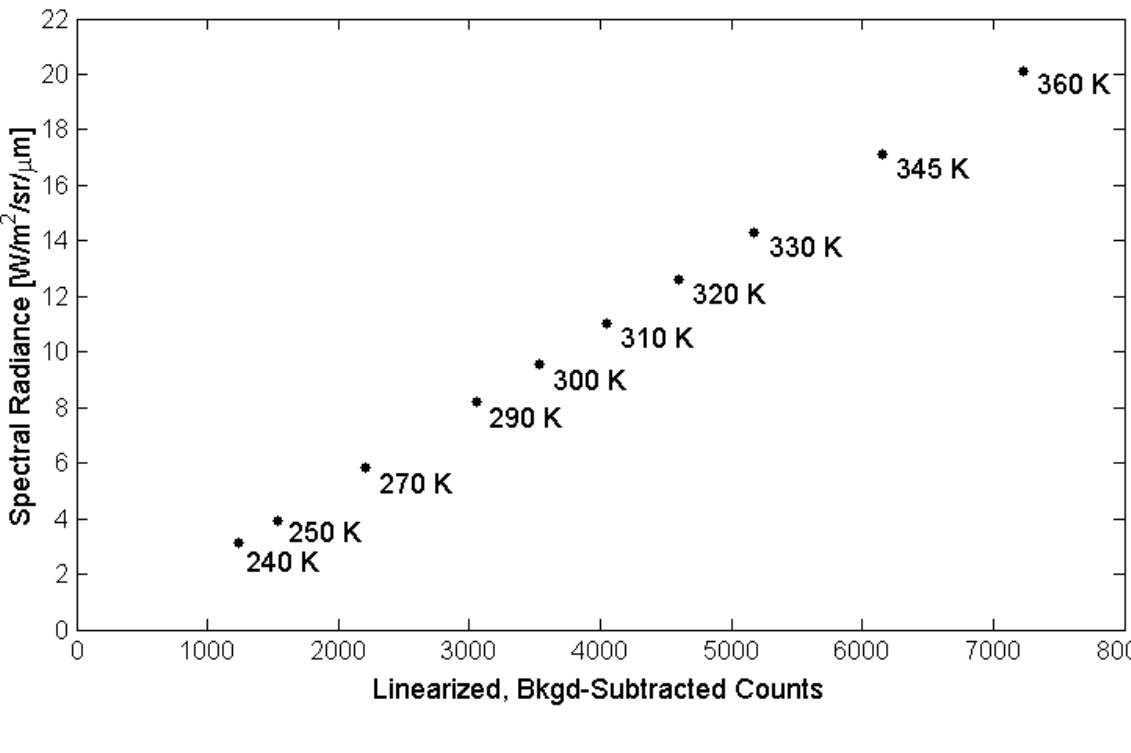
Figure 5. Calculated incident spectral radiance for ten source temperatures as a function of the measured source signal (linearized background-subtracted counts) for one detector in the 10.9 µ m band (Band 10) on the center focal plane array (SCA-C) from measurements taken during the instrument pre-flight thermal-vacuum (TVAC)